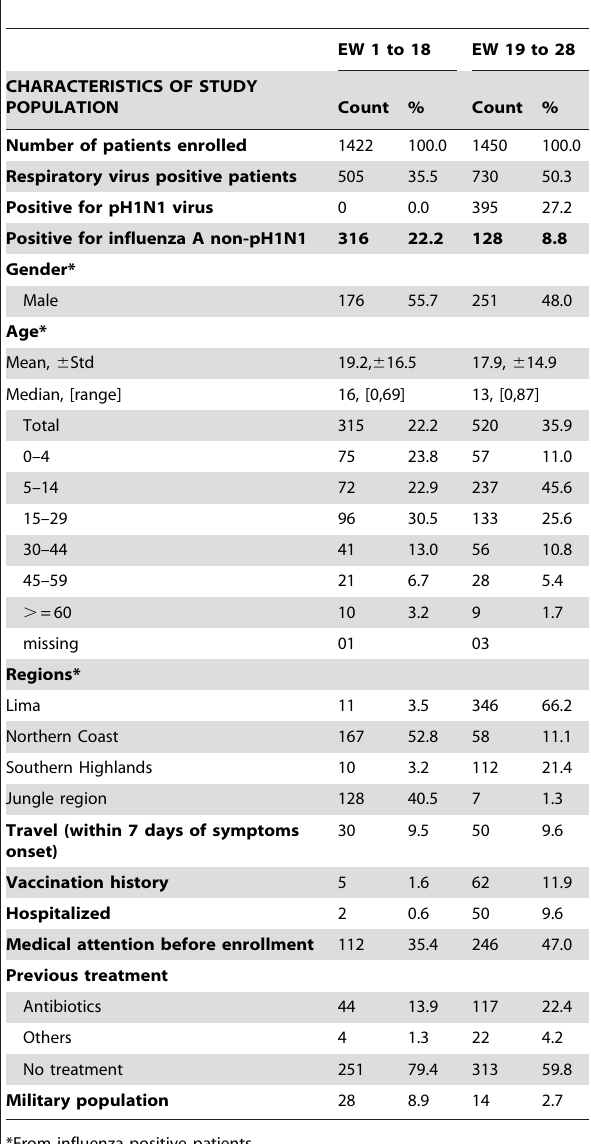
*From influenza positive patients. Table 1 shows the total number of patients enrolled in the study, the number of positive cases for at least one virus by isolation or rRT-PCR and describes general characteristics of non-pH1N1 influenza A cases and pH1N1